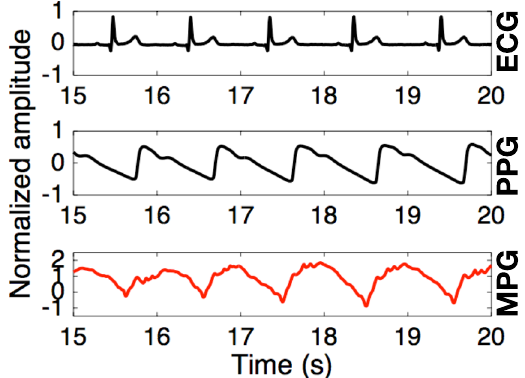
Figure 7. Cardiac activity captured from inside the ear canal using the multimodal sensor embedded within the earpiece. (Top) ECG signal from the arms. (Middle) PPG signal from the finger. (Bottom) Integral of the mechanical signal produced by the microphone within the multimodal